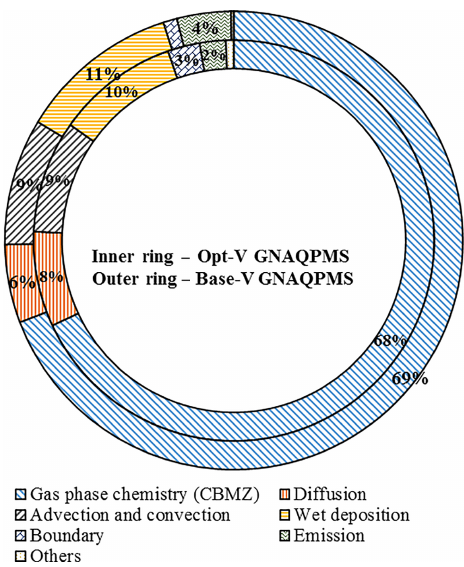
Figure 2. Overhead proportions of Base-V GNAQPMS (outer ring) and Opt-V GNAQPMS (inner ring). The top five most time- consuming modules were CBM-Z, diffusion, advection, wet depo- sition and boundary